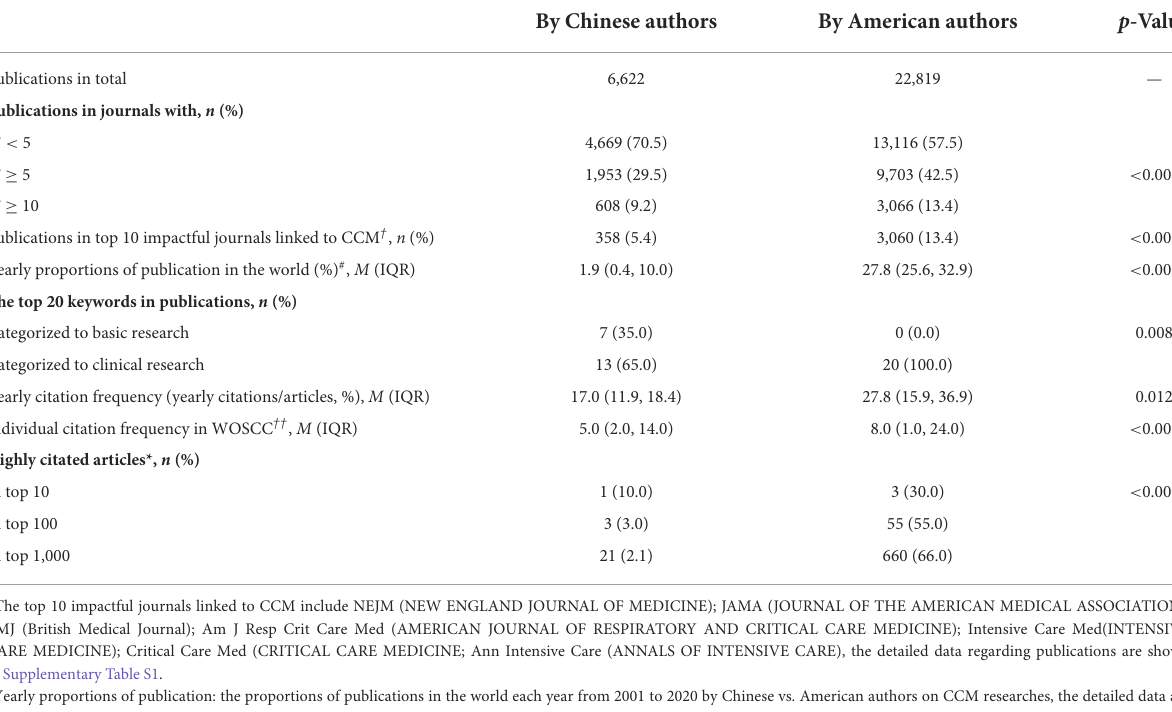
TABLE 1 Publications and the citations by Chinese vs. American authors from 2001 to 2020.